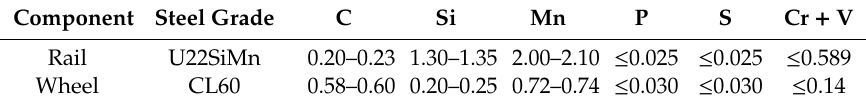
Table 1. Chemical composition (% of wt.) of selected rail and wheel steels.